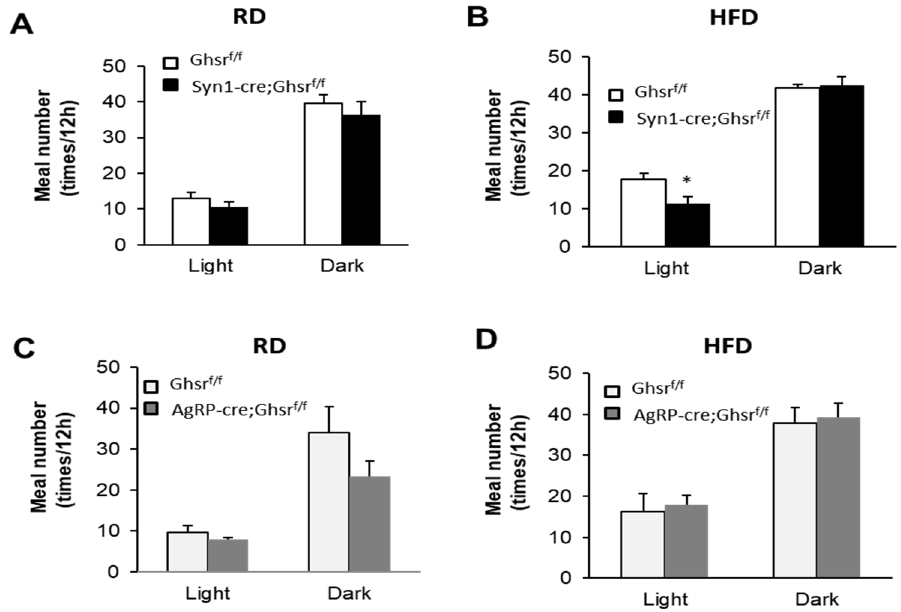
Figure 1. Meal number in Syn1-Cre;Ghsr f/f and AgRP-Ghsr f/f mice. RD ( A , C ) and HFD ( B , D ), n = 5, * p < 0.05, Ghsr f/f vs. Syn1-Cre;Ghsr f/f or AgRP-cre;Ghsr f/f . All data are presented as means ± SEM. * p < 0.05, Ghsr f/f vs. Syn1-Cre; Ghsr f/f or AgRP-cre; Ghsr f/f . All data are presented as means ±